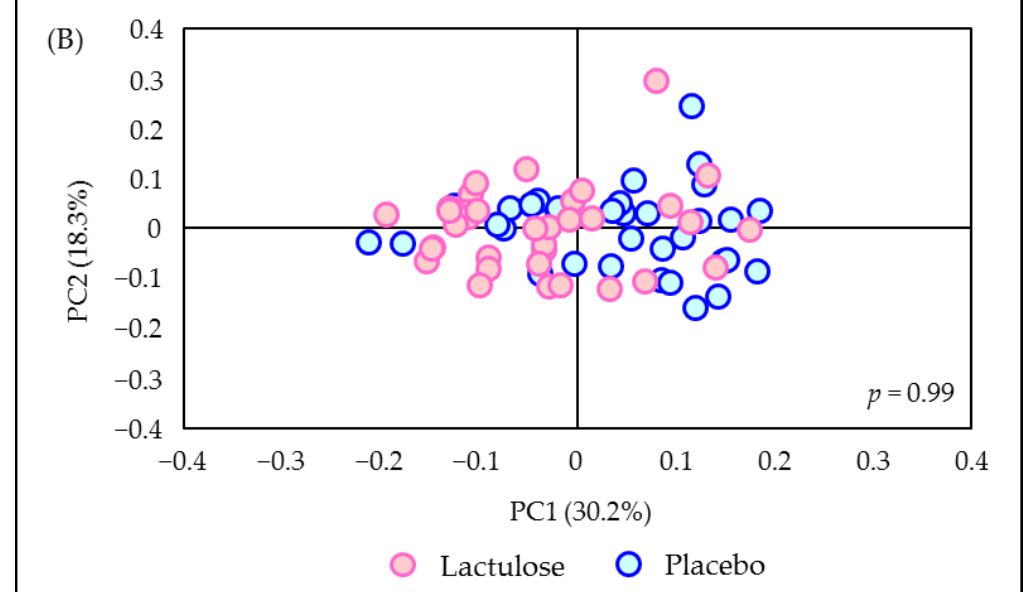
Figure A4. Principal coordinate analysis score plots generated using the first two principal coordinates (PC1 and PC2) based on data on the abundance of intestinal microbiota. Data were analysed using permutational multivariate analysis of variance and were based on ( A ) unweighted UniFrac distances or ( B ) weighted UniFrac distances. The differences between groups were not significant using the unweighted UniFrac distances ( p = 0.99) or weighted UniFrac distances ( p = 0.99).